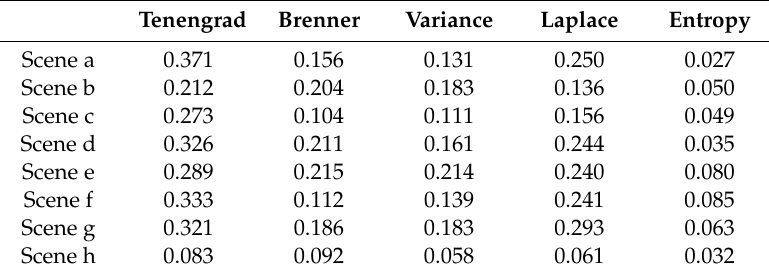
Table 6. Ef values of different IEFs in the eight scenarios.